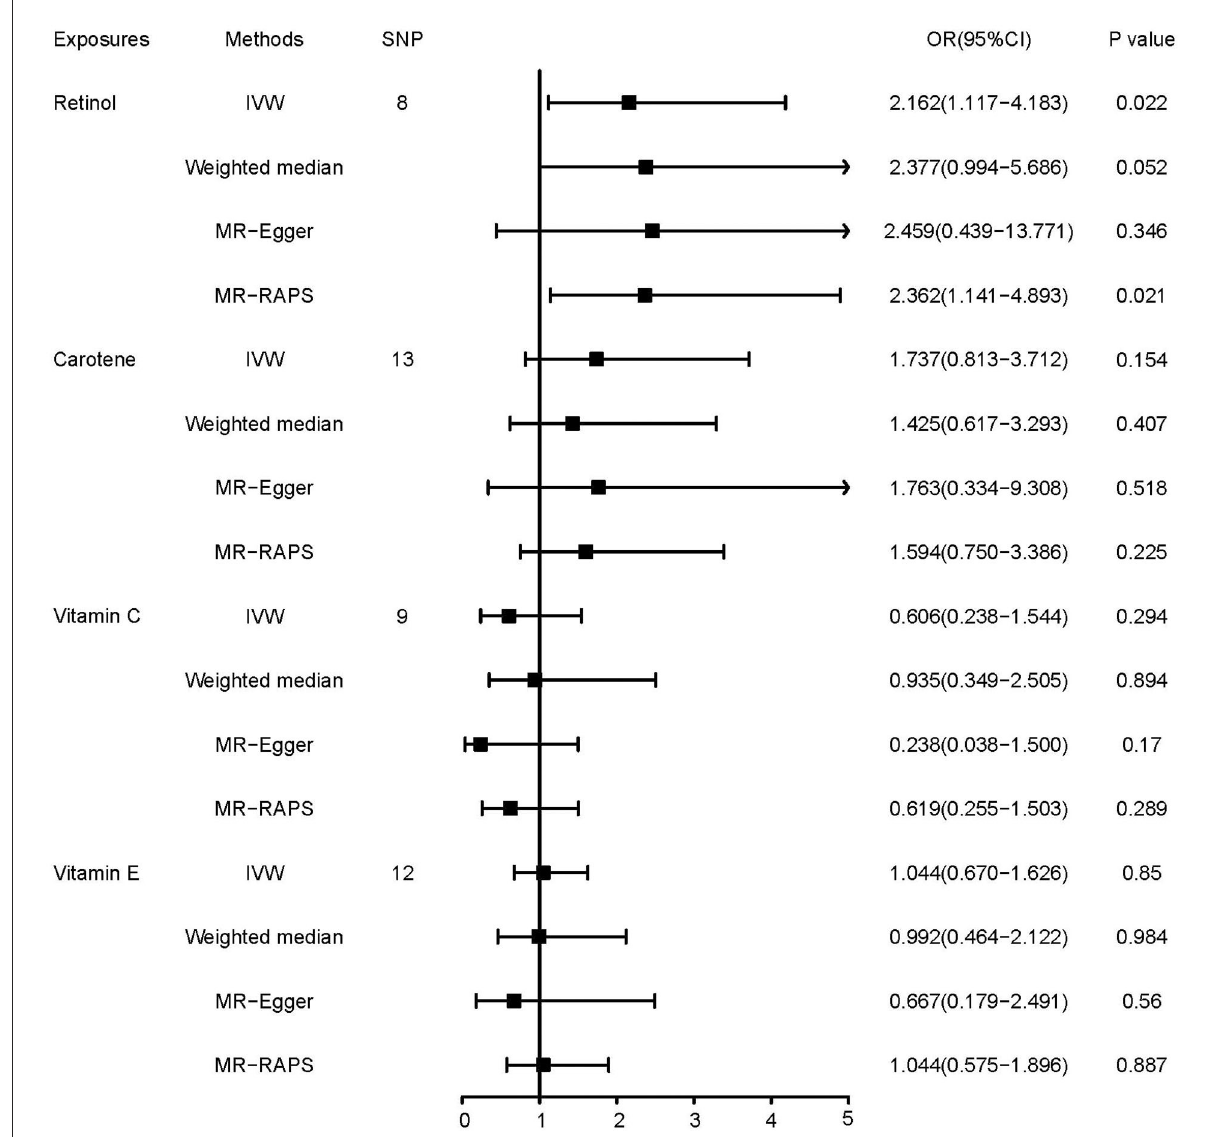
FIGURE2 Mendelian randomization estimates of the associations of antioxidant vitamins with squamous cell lung